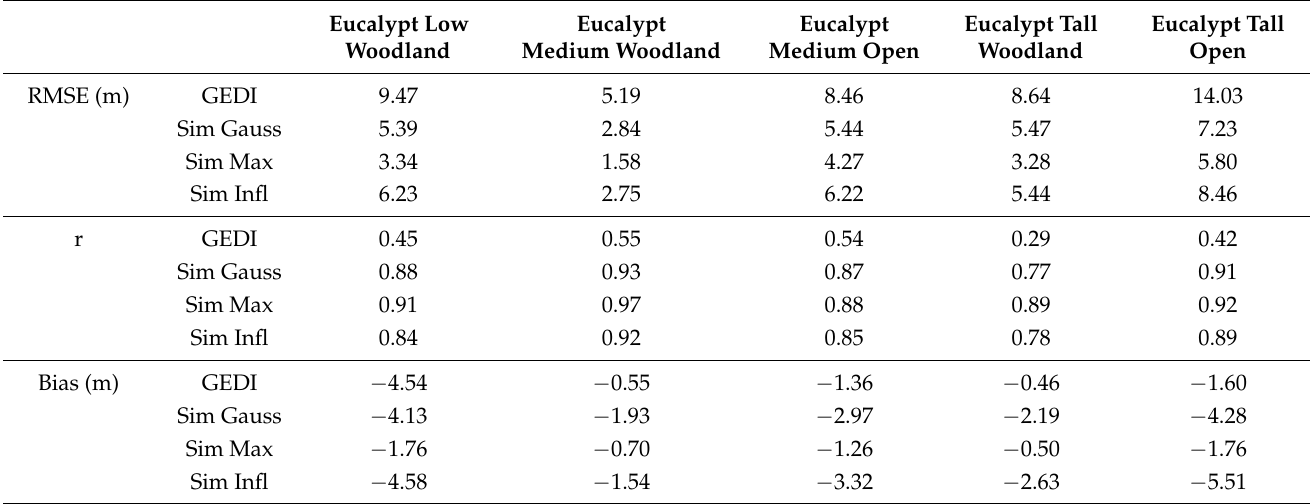
Table 4. RMSE, Pearson correlation r, and bias of real and simulated (Sim) GEDI data (RH95) in different eucalypt forest